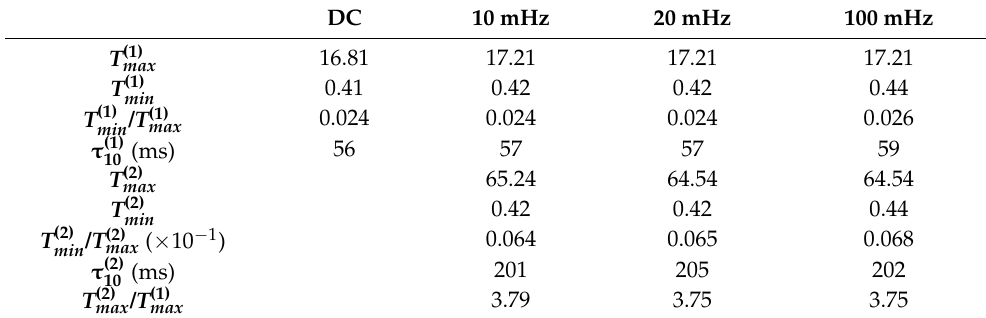
Table 1. The data of the T-t curves of the PDLC film applied with the DC voltage and the AC. DC 10 mHz